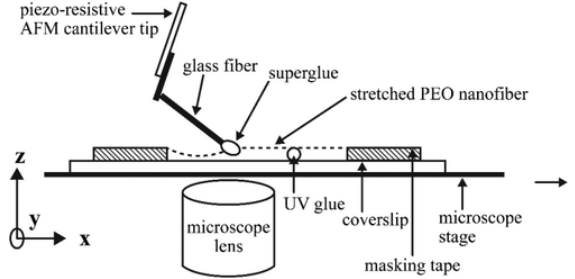
Figure 11. Diagram of single PEO nanofiber tensile test utilizing piezoresistive AFM tip. Reprinted from [114] with permission from AIP Publishing.